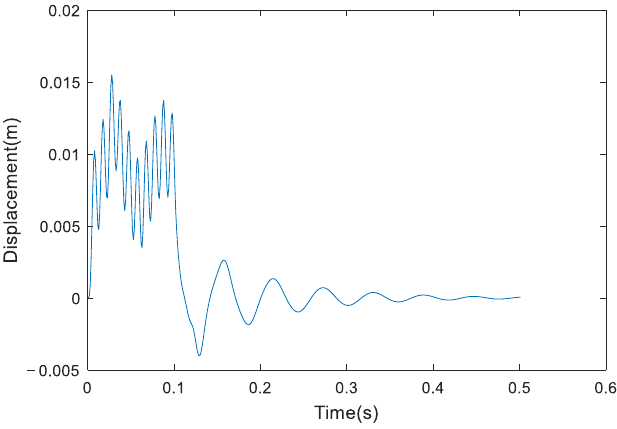
Figure 7. Displacement response of the top disk.